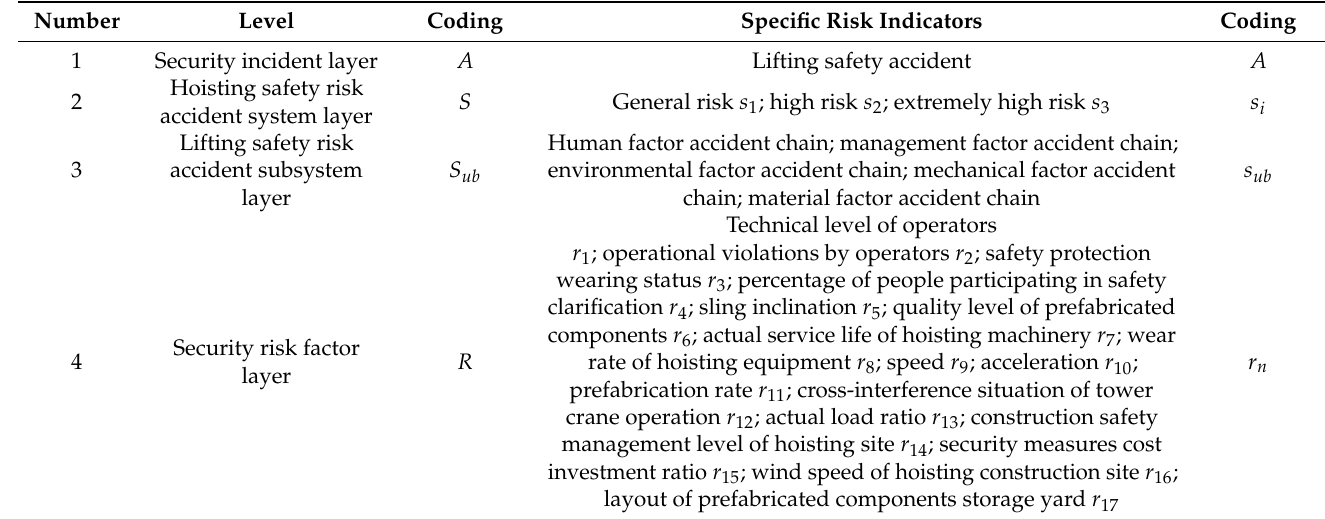
Table 1. Safety risk classification of the prefabricated building construction hoisting process.